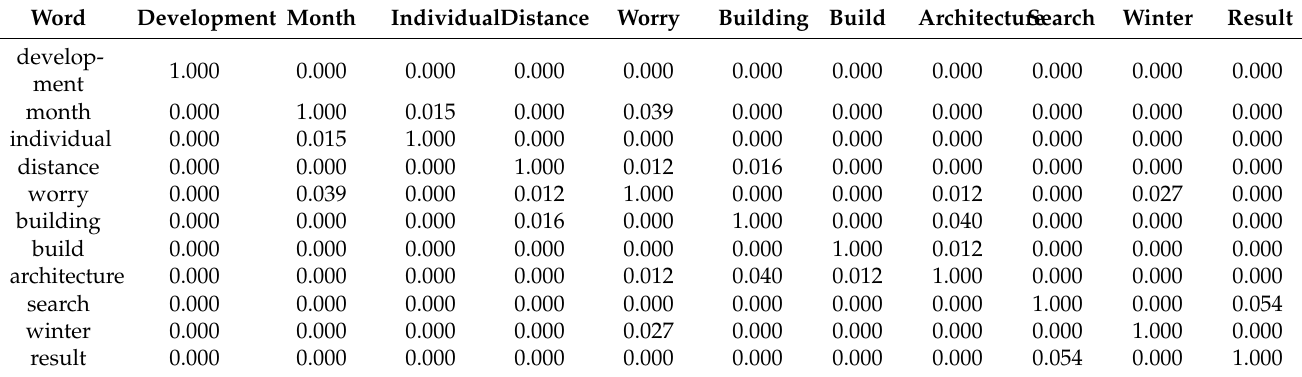
Table 3. Section of data frame showing TF-IDF weight values between pairs of words.